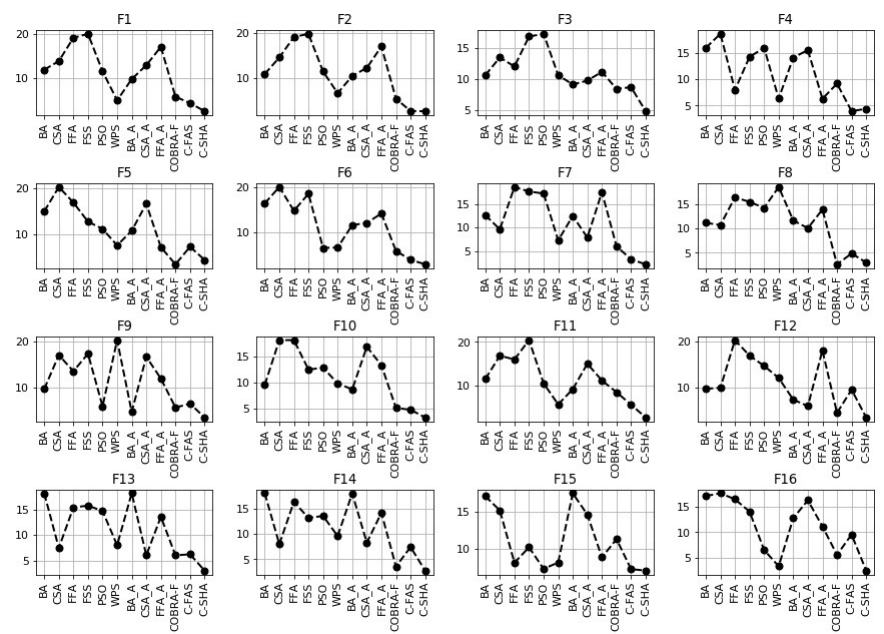
Figure 9. Results of the Friedman statistical test for